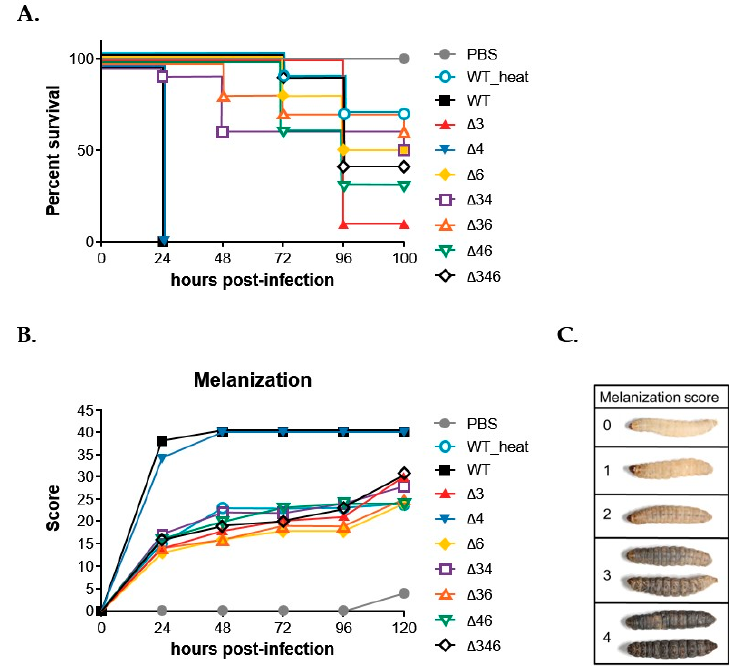
Figure 9. G. mellonella survival rates and melanization scores after infection with A. baumannii ATCC 19606 wild-type (WT) and mutant strains. ( A ) Kaplan–Meier survival curves, with each curve representing a single experiment performed with 10 larvae. ( B ) Melanization score curves. ( C ) Pictorial definition of melanization scores for reference. Larvae were infected with 5 × 10 6 CFU of wild-type or mutant strains, with PBS used as the buffer and serving as a control. WT_heat indicates wild-type A. baumannii treated at 100 ◦ C for 10